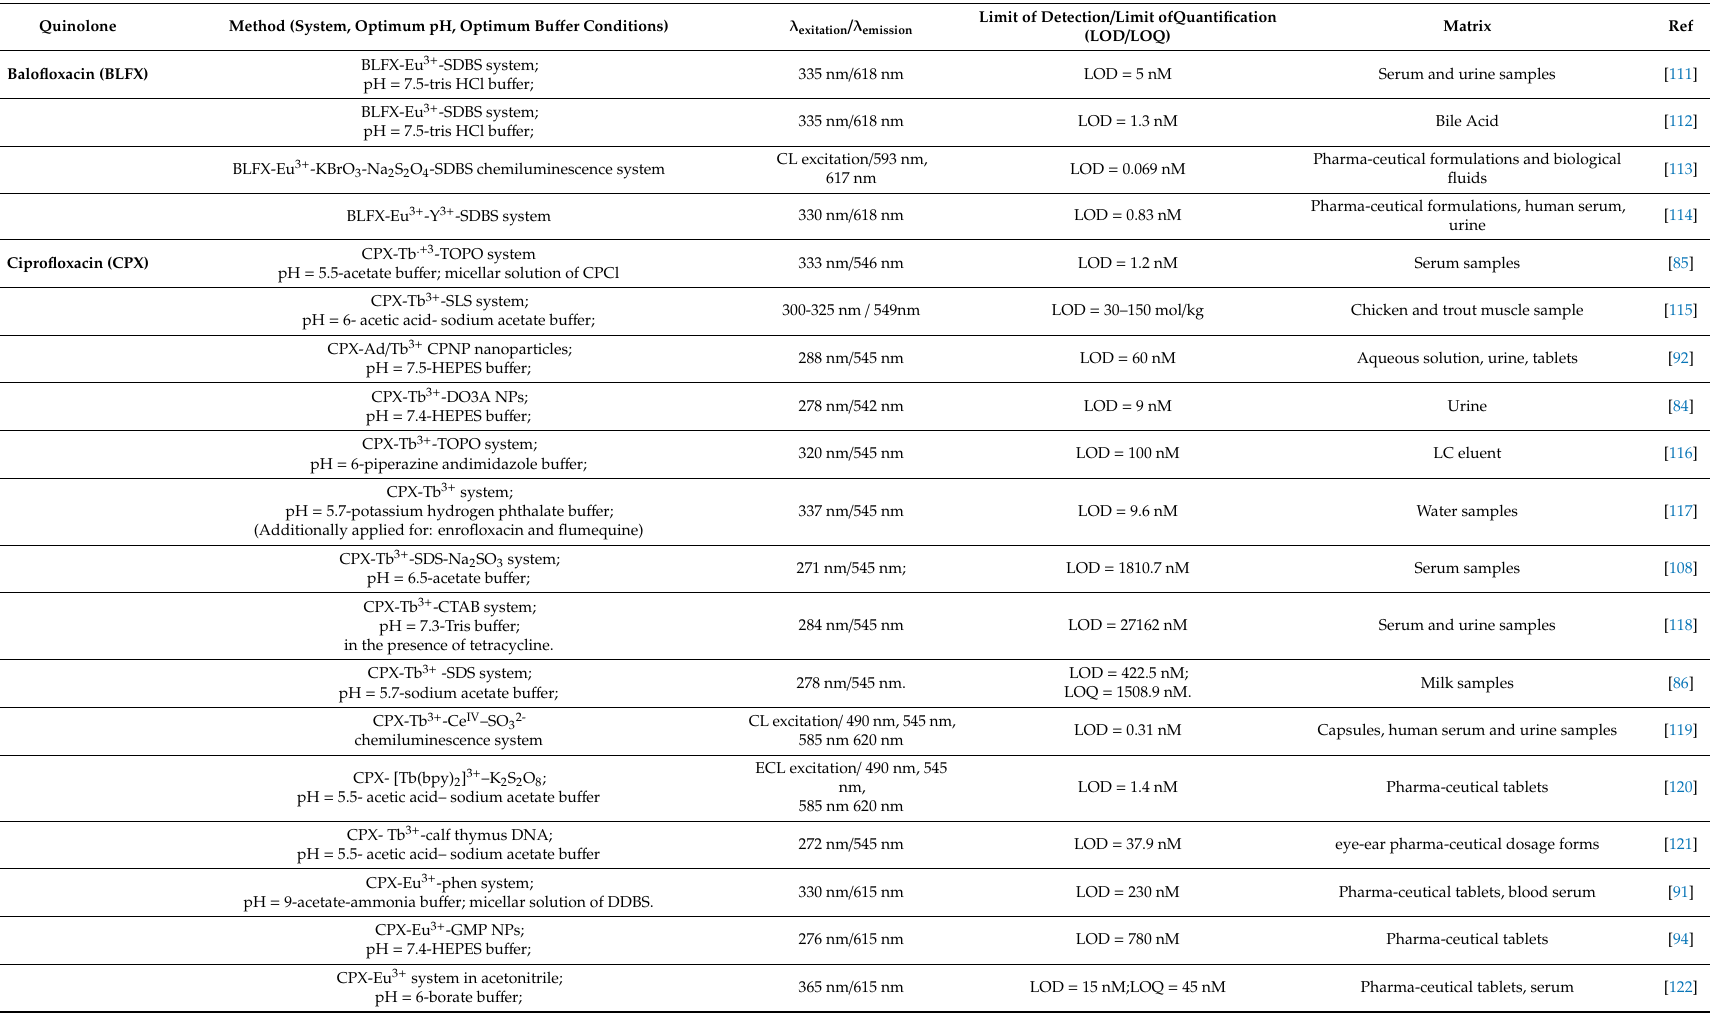
Table 4. Methods for quantitative determination of quinolones based on complexation with